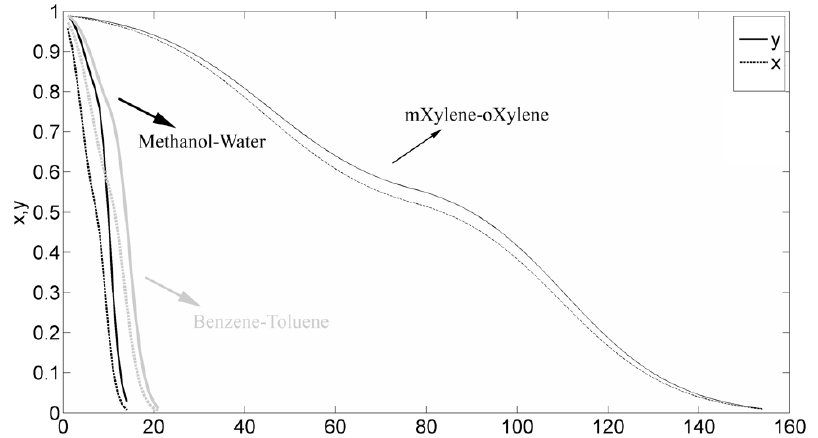
Figure 4. Predicted mole fraction of light component in vapor and liquid phases by graphical model for conditions of Table 2.